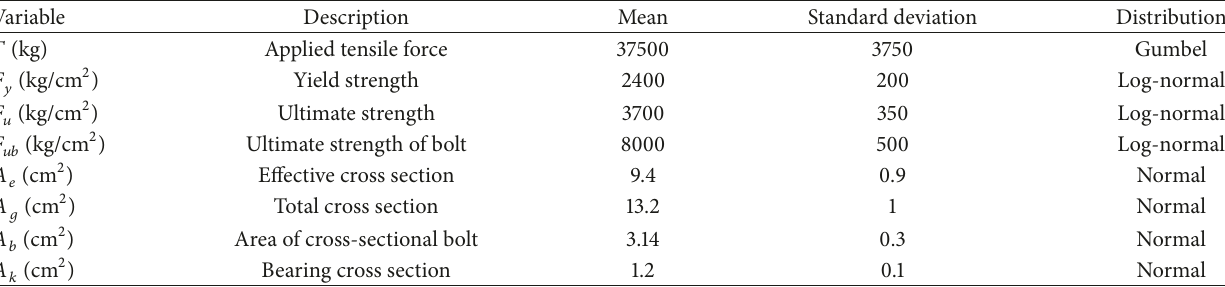
Table 4: Statistical characteristics of random variables for the connection example.